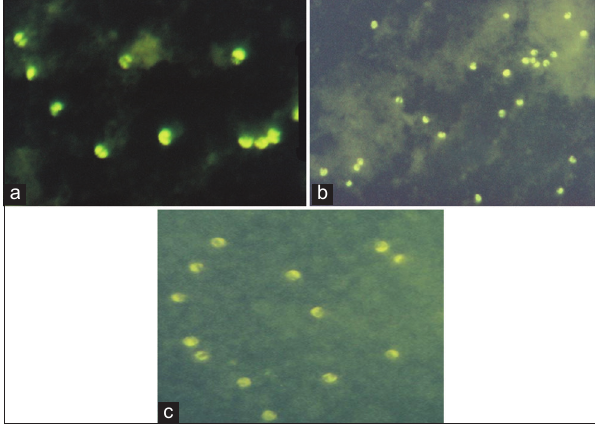
Figure-2: Toll like receptor-9 (a), CD4 (b), CD8 (c) expression in Rabbit T cells, visualized by fluorescein isothiocyanate (400×